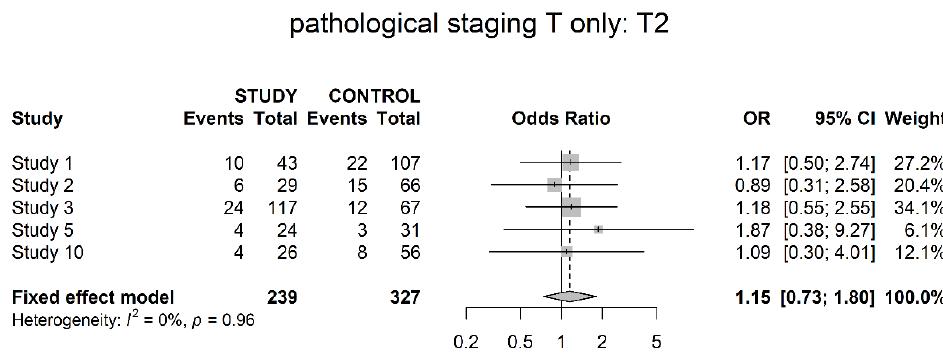
Figure 4. Pathological stage T2 (muscle-invasive).